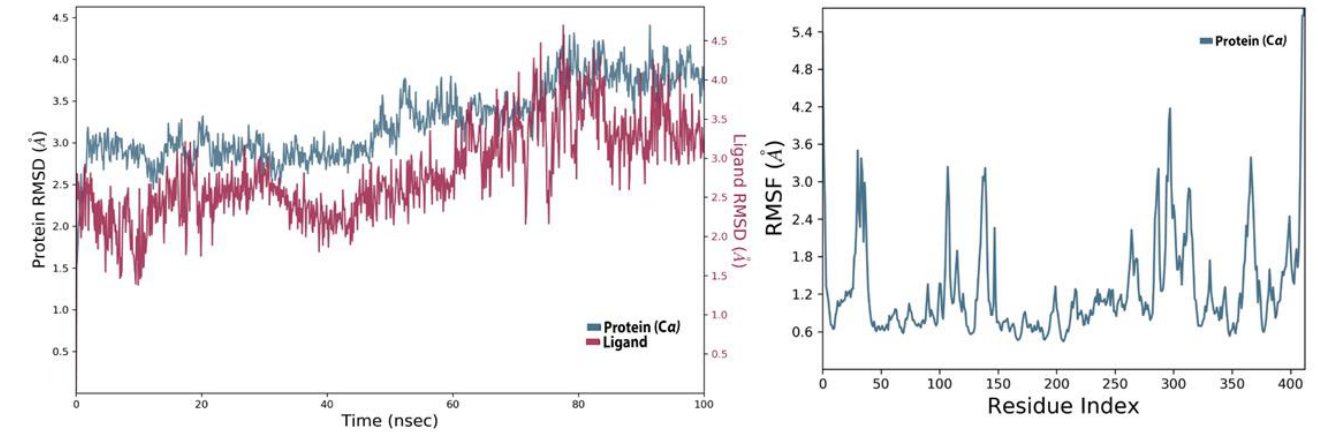
Figure 8. RMSD and RMSF of SARS-CoV-2 NSP10/NSP16 MTase and CHEMBL2229121 complex.